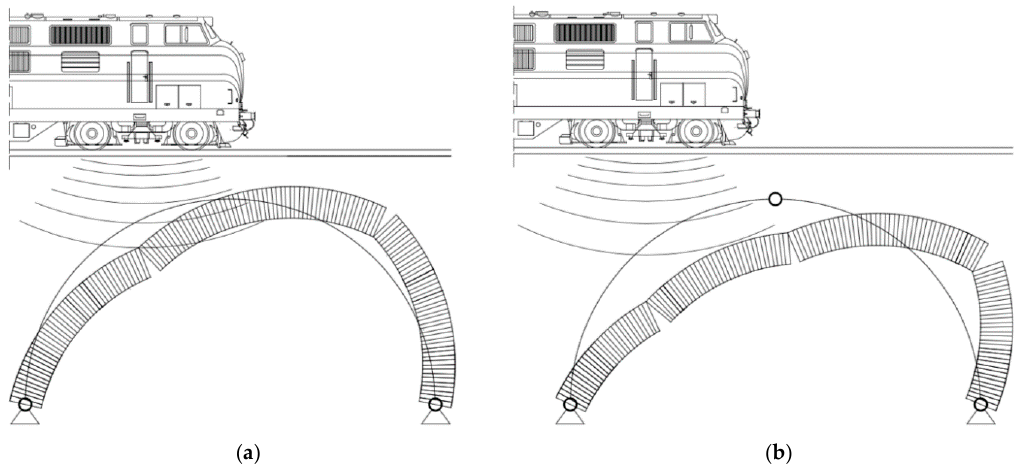
Figure 16. The potential collapse mechanisms for: ( a ) The two- and ( b ) three-hinged arches.